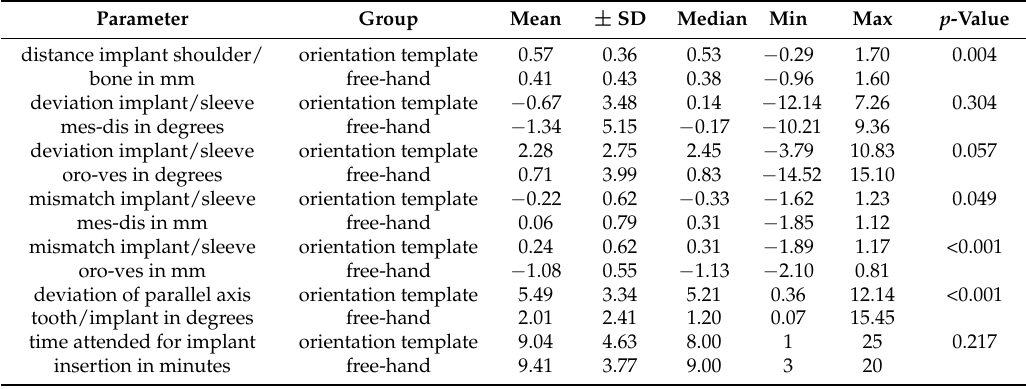
Table 2. Pair-wise comparison of the parameters between the use of the orientation template and free-hand implant insertion. The mean values, median values, standard deviations of the mean values (SD), and the p -values are depicted. A “+” means a deviation in mesial or oral direction. A “ − “ refers to a deviation in distal or vestibular direction. Statistically significant differences are marked in bold font. Group Mean ± SD Median Min p